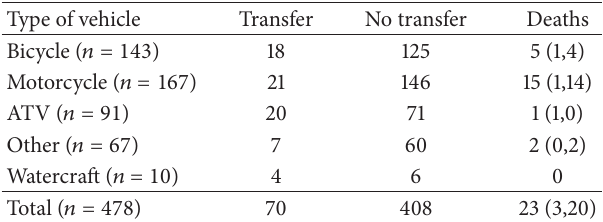
Table 2: Types of vehicles, transfer status, and deaths.